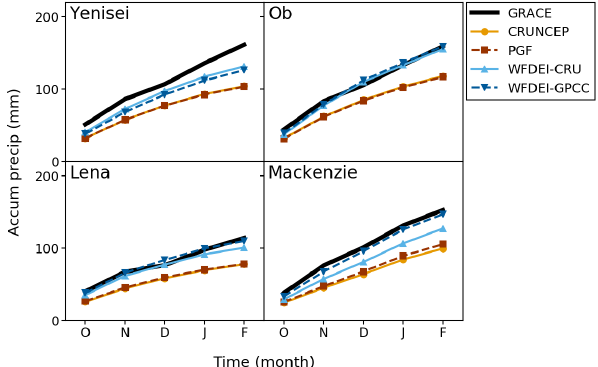
Figure 3. Climatology of monthly maximum SWE (mm) from ob- servations and from the CTL model runs averaged over the common overlap period,